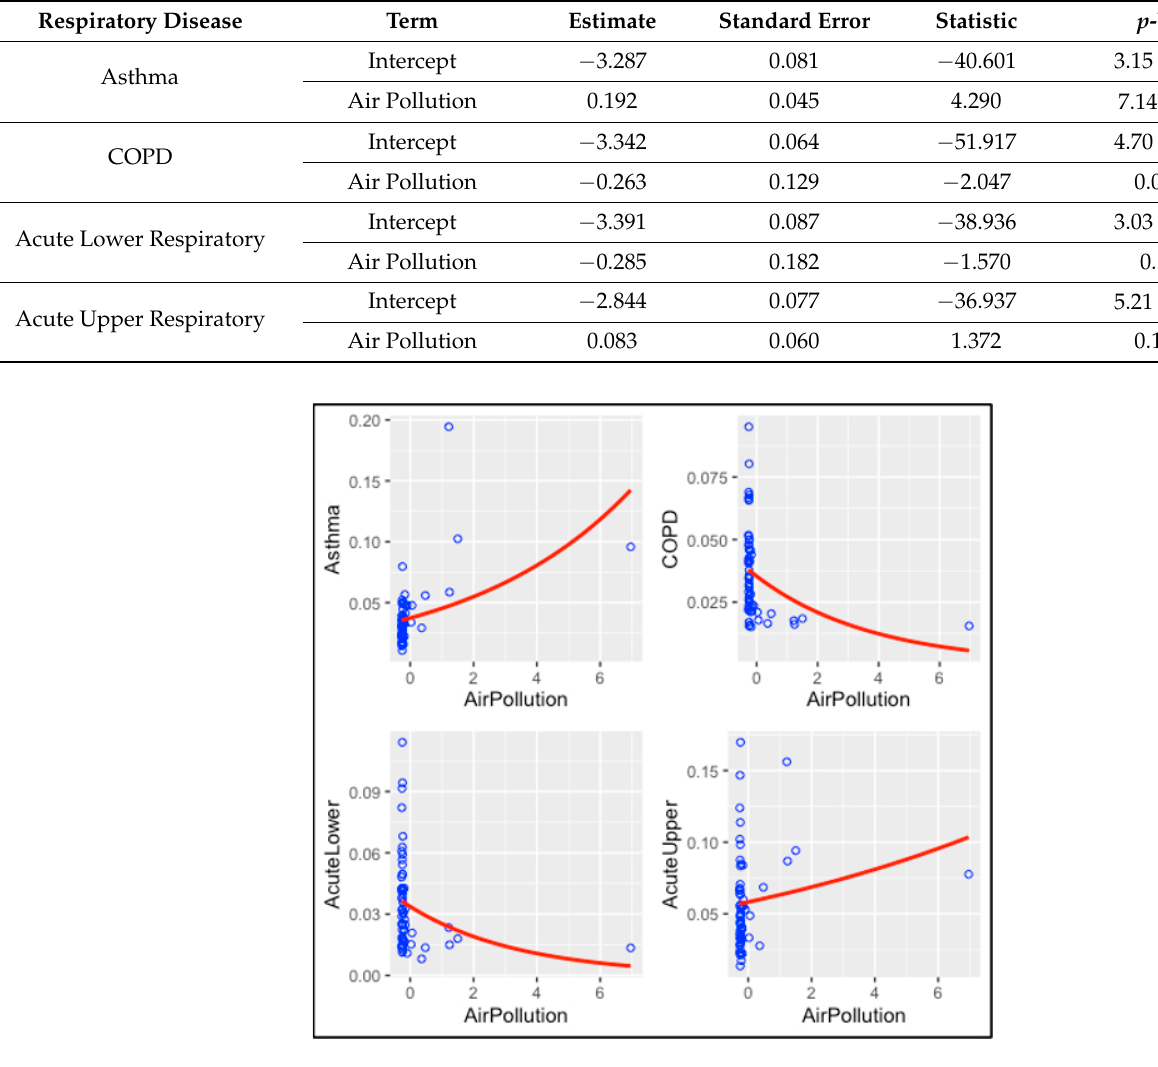
Figure 4. The association between air pollution and respiratory diseases . Table 2. The association between air pollution and respiratory